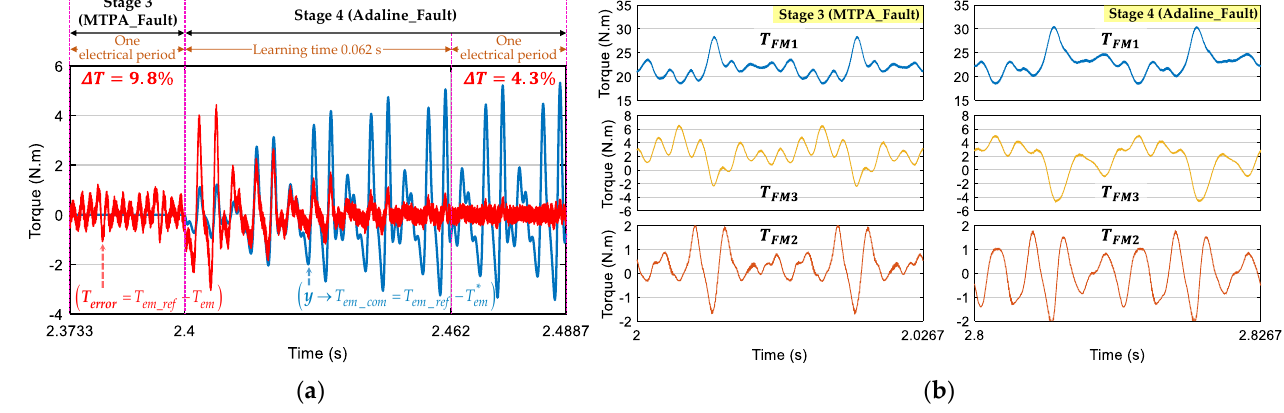
Figure 6. (Numerical result) Switch from stage 3 to 4 when phase A is opened at 750 rpm: ( a ) elimi- nation of T error with the proposed Adaline-based scheme ( η = 0.0003) in stage 4; and ( b ) torques of three fictitious machines T FM 1 , T FM 2 , and T FM 3 in one electrical period.